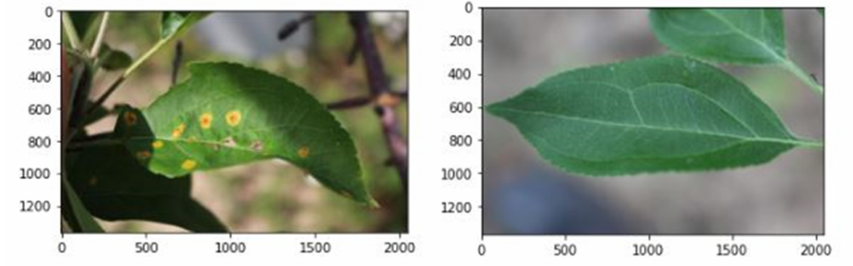
Figure 2. Leaves examples.